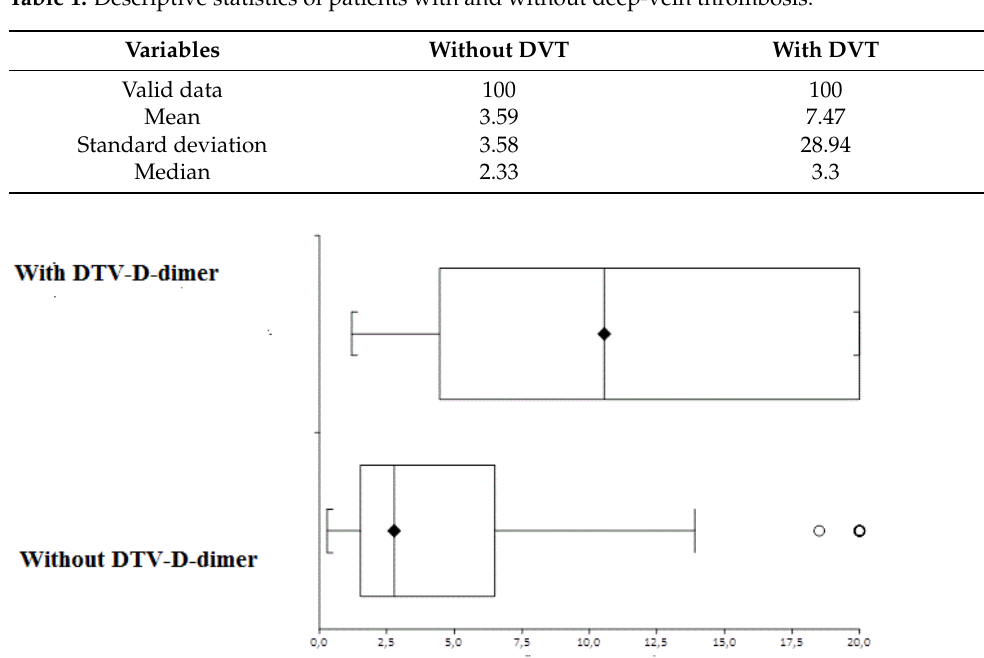
Table 1. Descriptive statistics of patients with and without deep-vein thrombosis.